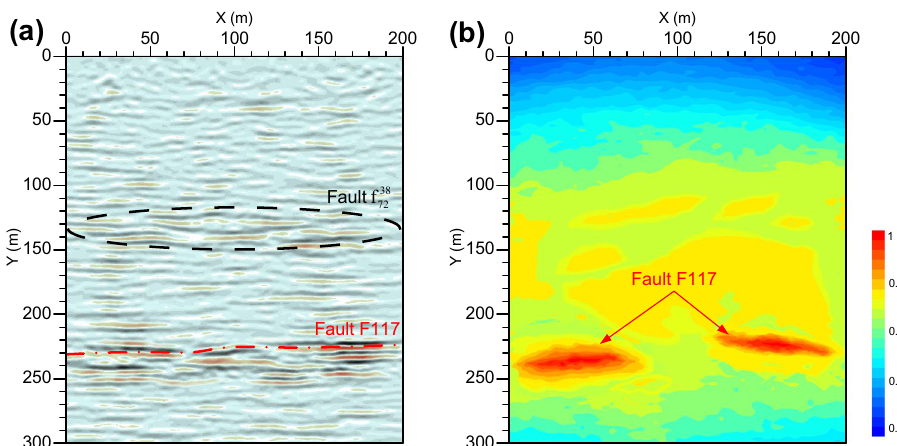
Fig. 16 Depth profiles of the field study using the method in this study: a P -wave, b Rayleigh channel